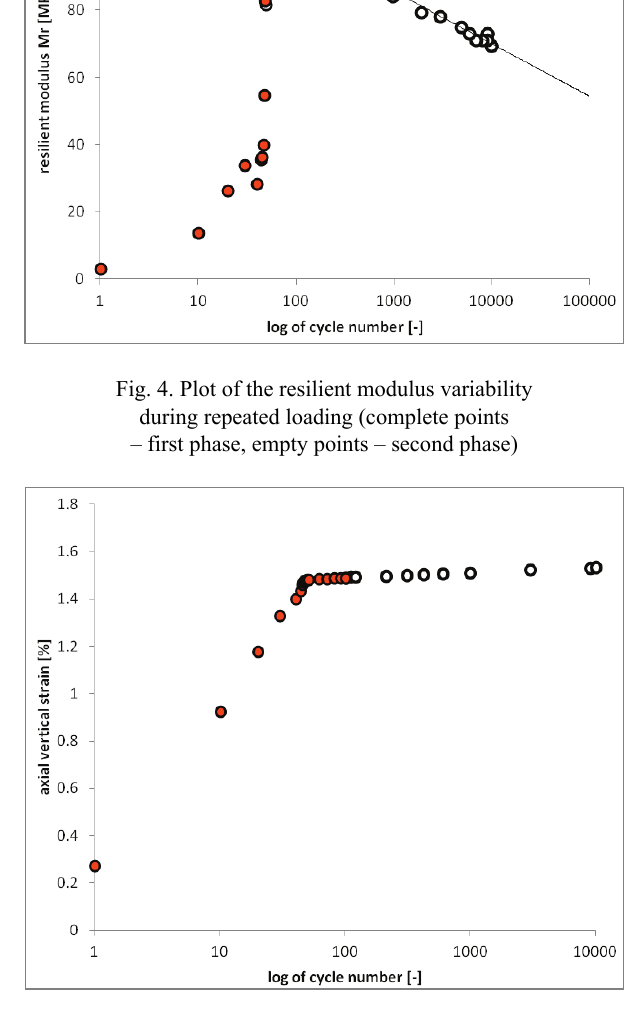
Fig. 5. Plot of the vertical strain during repeated loading test (complete points – peak resilient modulus value, empty points – phase of the resilient modulus